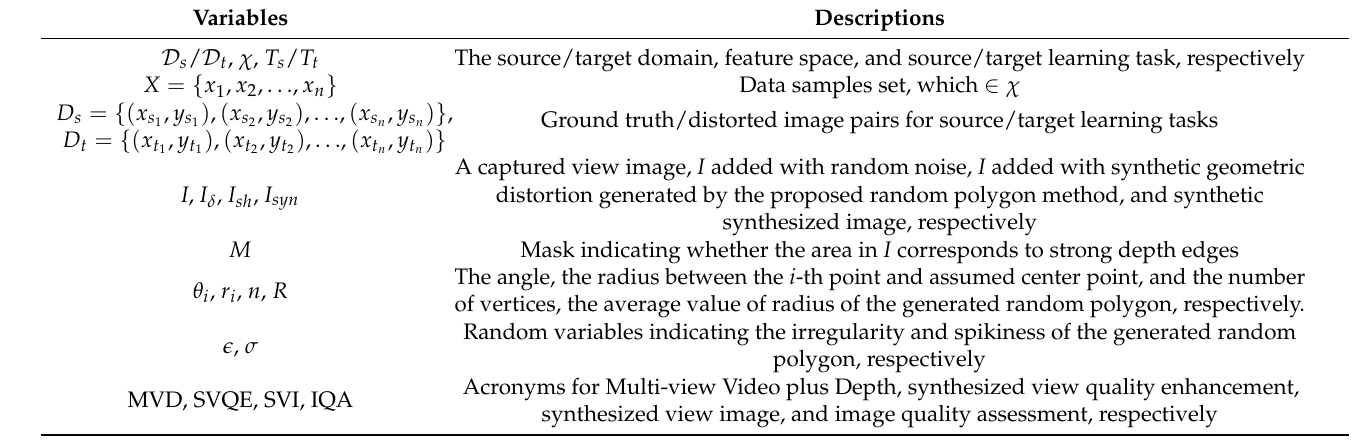
Table 2. Definitions of key variables and